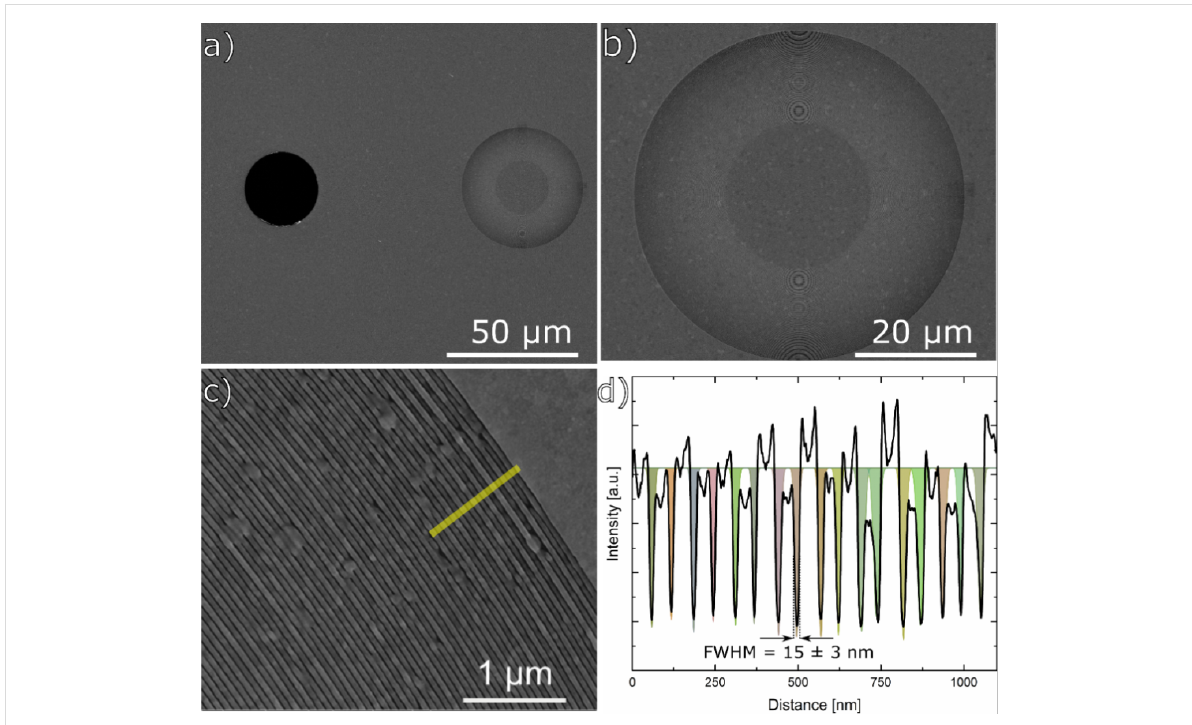
Figure 2: SEM images of M-IV IBL-FZP prior to the beamstop deposition. a) An overview image. The FZP and the reference aperture are shown side by side. b) A higher-magnification image showing the empty central portion and the active zones of the FZP. The circular structures over the zones are due to a moiré effect during imaging. c) Top-right part of the FZP. 60 nm wide periods can be seen. d) The line profile taken from a region roughly 30 pixels wide marked in c. The lines written with the ion beam are fitted with a Gaussian curve with an average FWHM of 15 ± 3 nm. The measured line-to-space ratio for the outermost period is roughly 2.5:1 (ca. 43:17 nm). All SEM images were recorded under normal